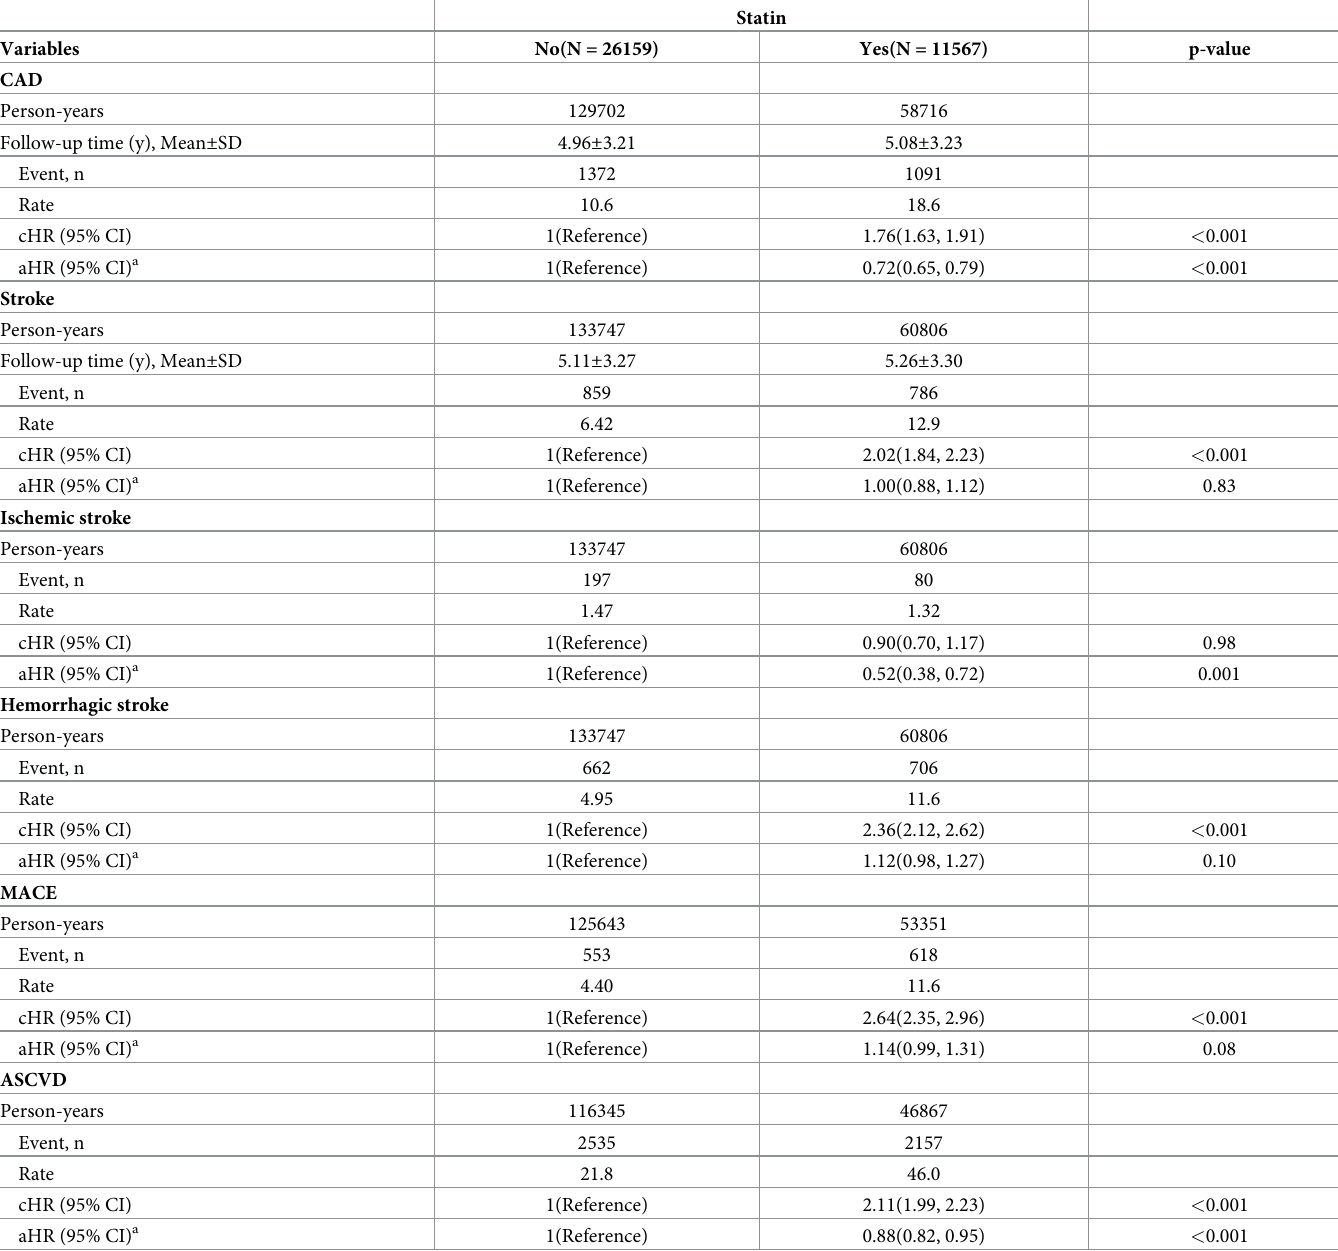
Table 2. Overall Incidence of coronary artery disease and stroke (per 1,000 person-years) and estimated hazard ratios in interstitial lung disease and pulmonary fibrosis patients with statin compared to the interstitial lung disease and pulmonary fibrosis patients without statin by time dependent regression